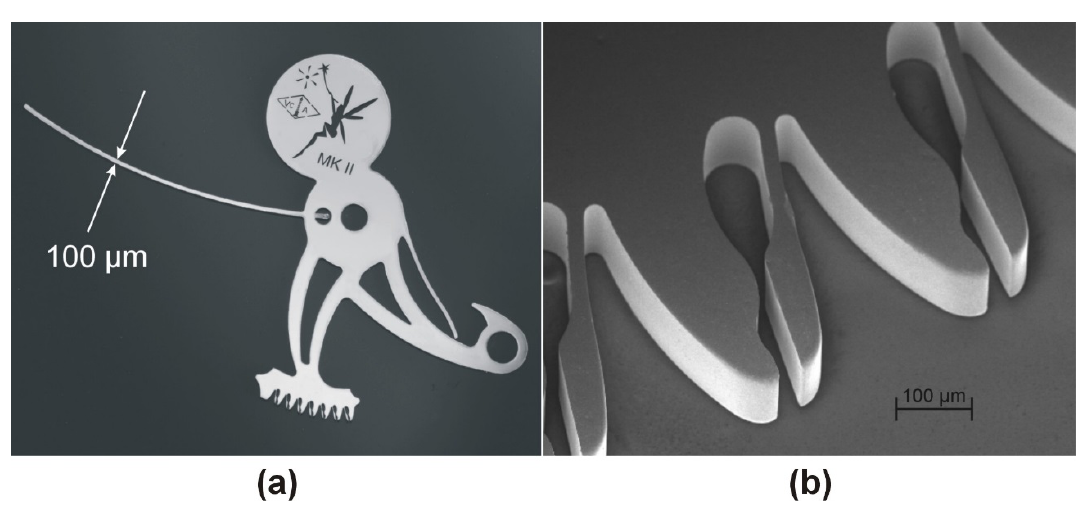
Figure 4. ( a ) Sector with identification number, integrated logo, springs and play-free engagement gearing; ( b ) SEM image of slotted-teeth. The spring part is 20 µm wide and 120 µm thick. Adapted from